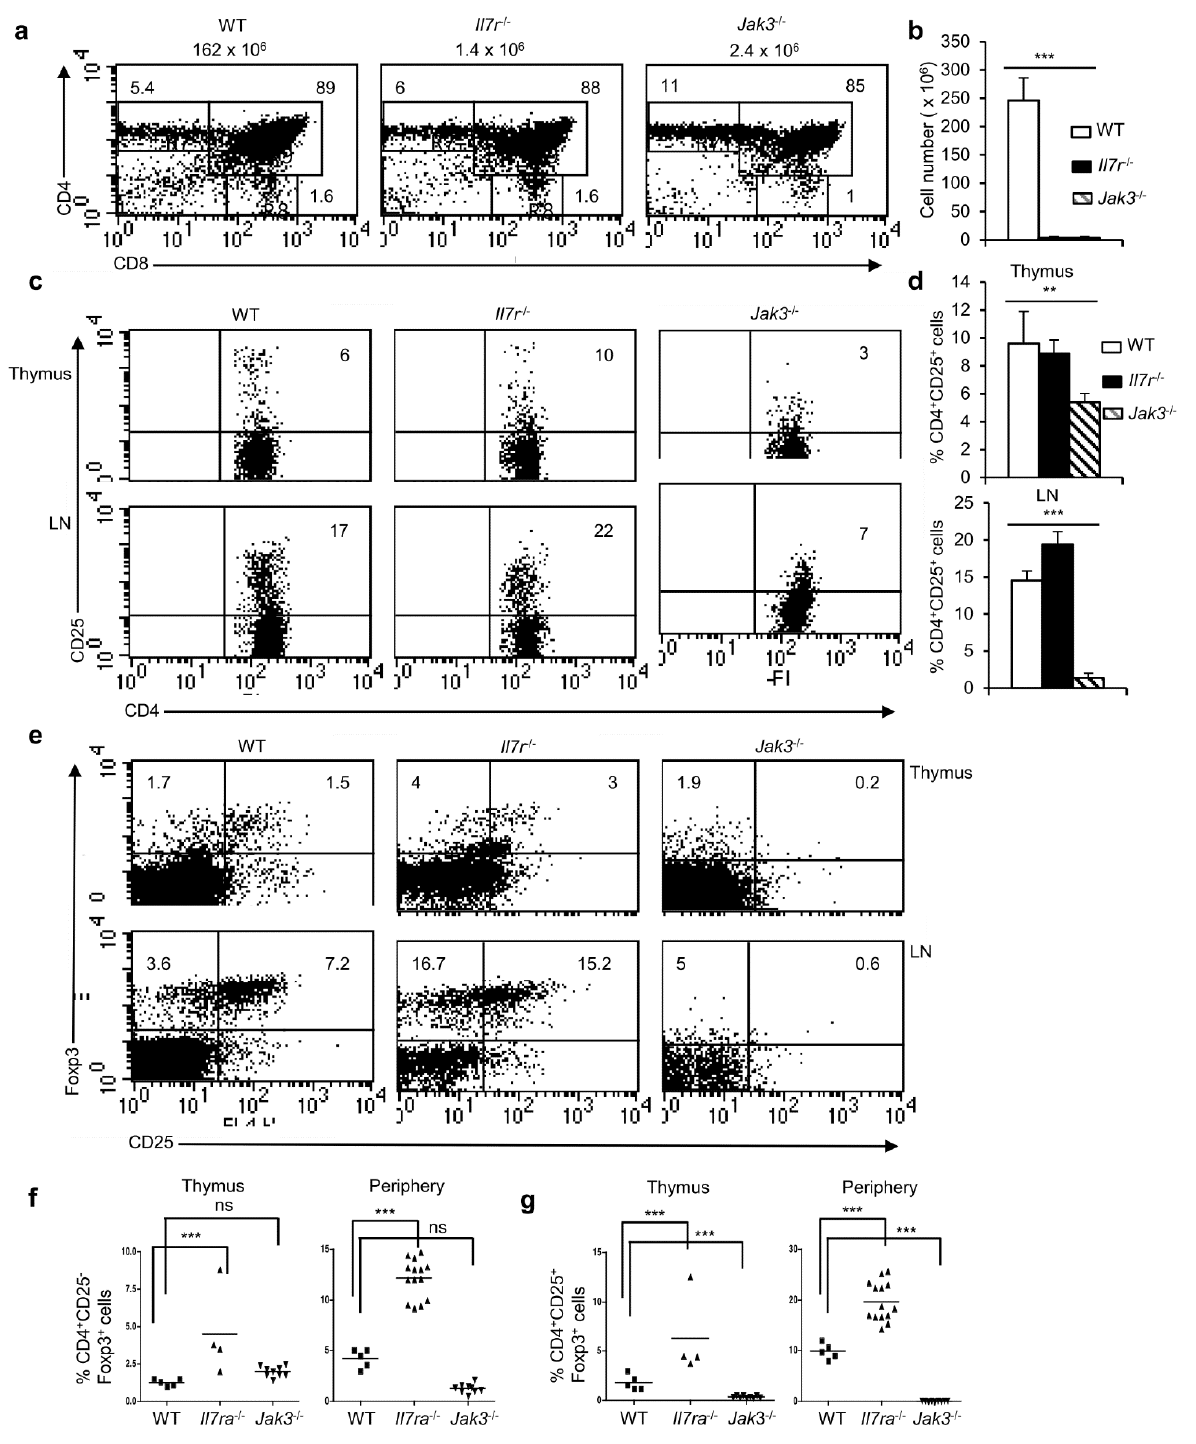
Figure 5. NFAT signaling is dispensable for the generation of Foxp3 + T reg cells. ( a ) Flow cytometry showing the distribution of thymocyte populations based on CD4 and CD8 stainings from WT, Il7r -/- and Jak3 -/- mice. Numbers atop each plot represent total cellularity and within each plot represent the percent distribution of respective populations. ( b ) Quanification of total thymic cellularity in WT, Il7r -/- and Jak3 -/- mice ( n = 7 each, *** p < 0.0001; one-way ANOVA). ( c ) Distribution of CD4 + CD25 +